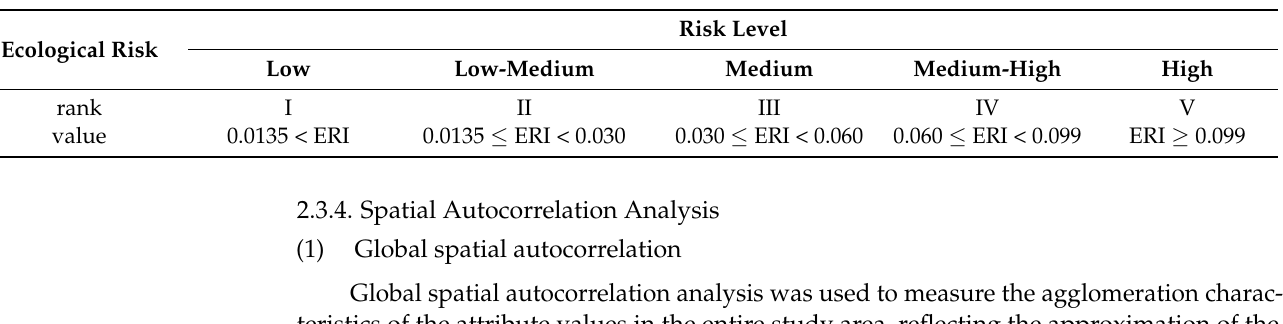
Table 2. Landscape ecological risk classification in the Yellow River Basin, Shaanxi Province,